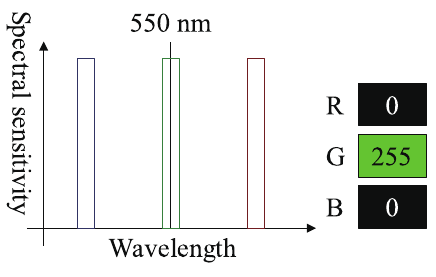
Figure 5. Example of camera spectral sensitivity which has channel crosstalk.